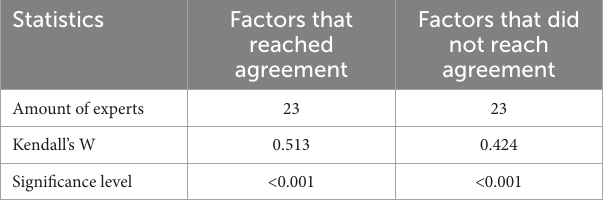
TABLE 5 Agreement index of factors with or without consensus in the 2nd round.